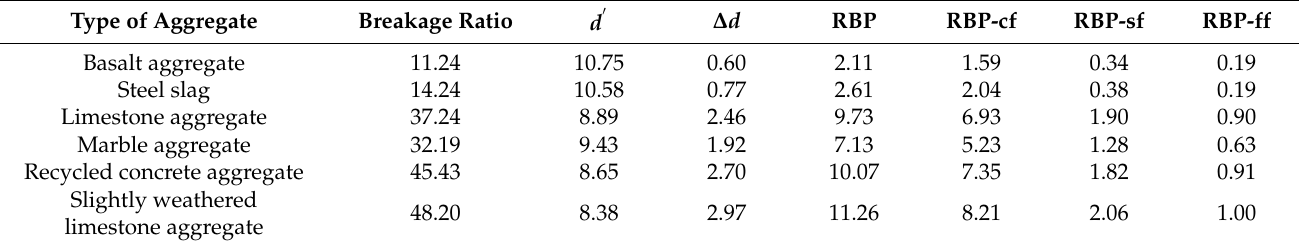
Table 10. Results of aggregate crushing characteristics after gyratory